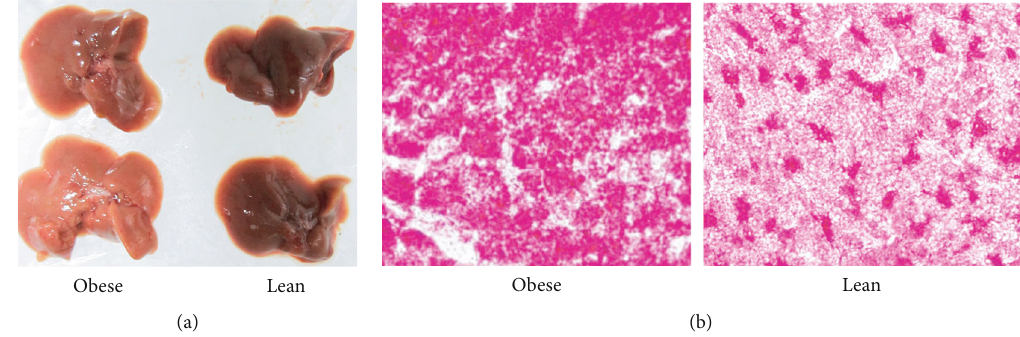
Figure 3: Liver character from obese and lean mice. (a) Unaided observation of the liver showed that the color of the liver became more yellow. (b) Oil red O staining of the liver specimen under a microscope demonstrated that lipid in cytoplasm became red with the help of oil red O, and the fi elds of the liver specimen from the obese group get more red than that from lean mice. Magni fi cation, × 400. Table 3: Serum metabolic and adipokine changes in mice. Groups Parameters